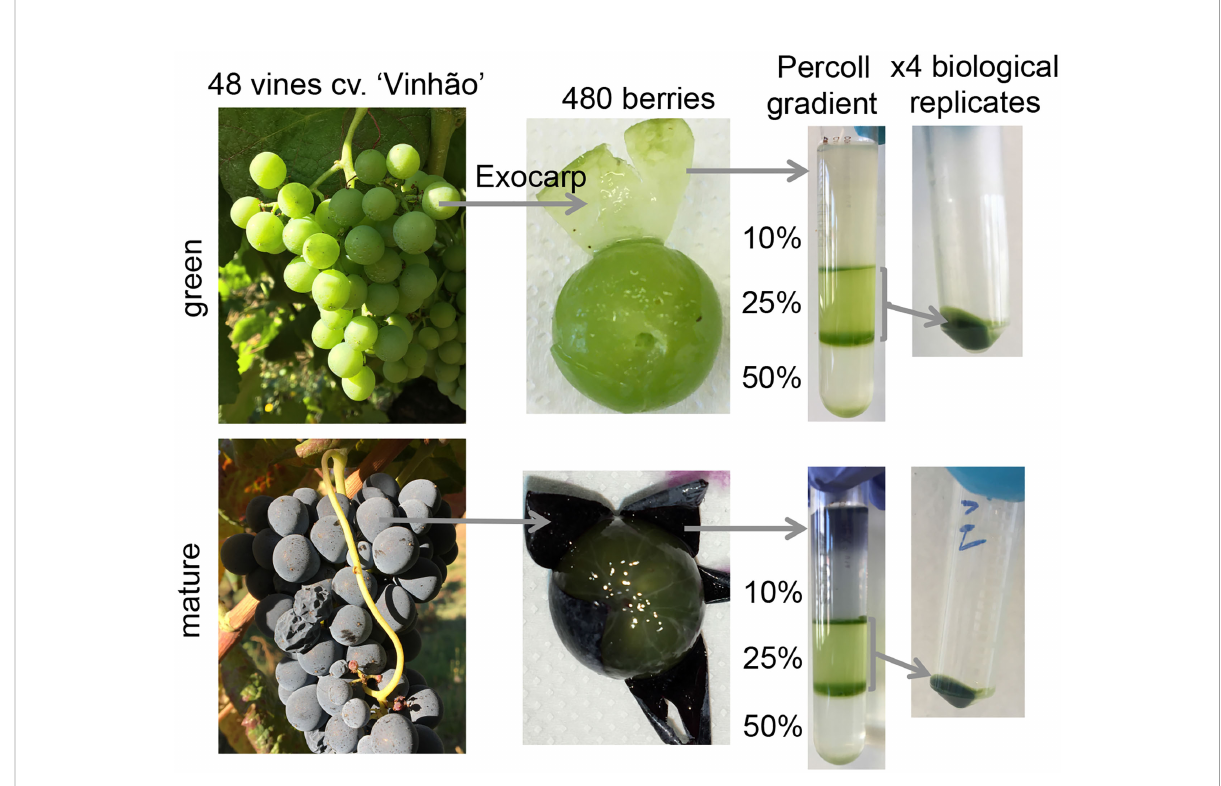
FIGURE 1 Plastid puri fi cation from the exocarp of Vitis vinifera cv. Vinhão at green (E-L 34) and mature (E-L 38) developmental